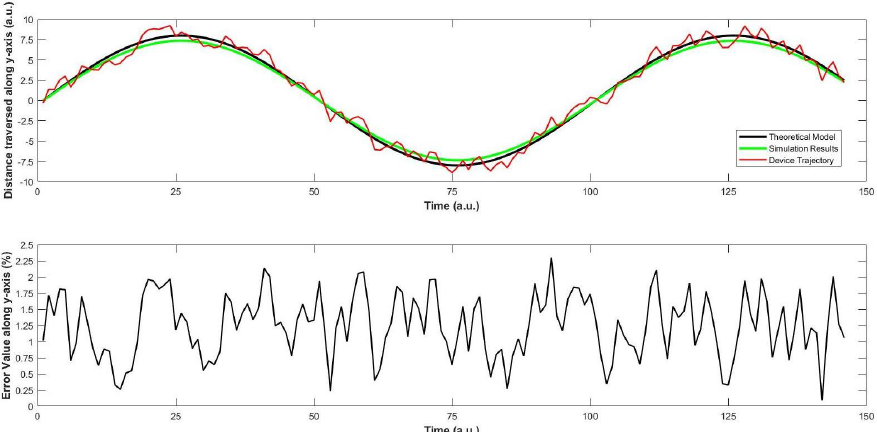
Figure 11. First trajectory scenario: Investigation of change in values of y. ( top ) shows a comparison between the ideal, simulation and actual (trajectory) values during the movement of the quad-copter along the y-axis, and ( bottom ) shows the average error between the simulated results and the actual (trajectory) values, which is very